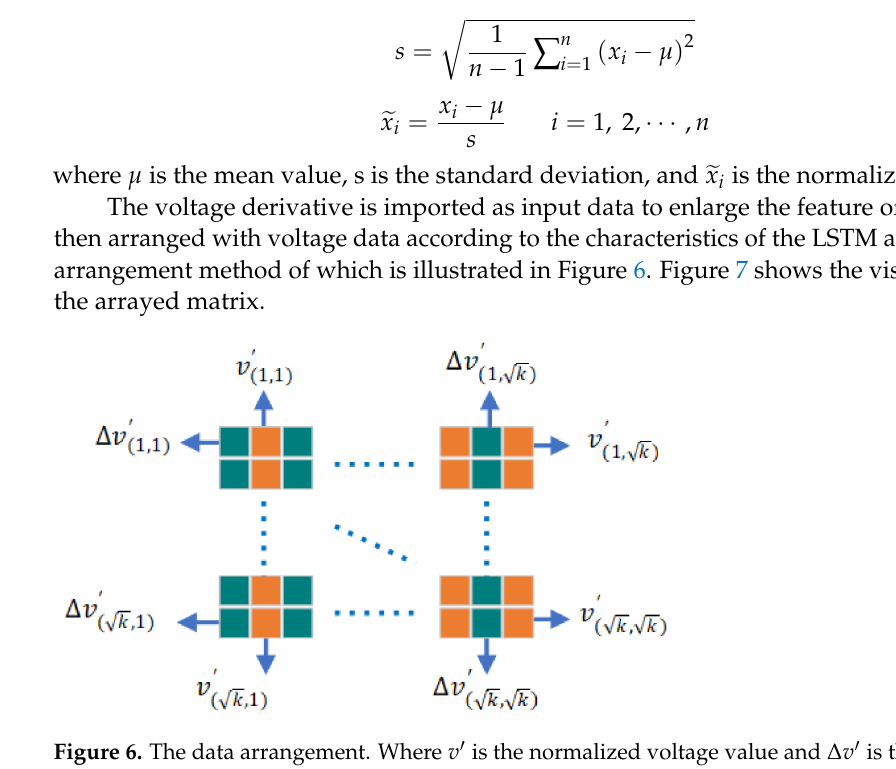
Figure 6. The data arrangement. Where v (cid:48) is the normalized voltage value and ∆ v (cid:48) is the normalized voltage derivative value.